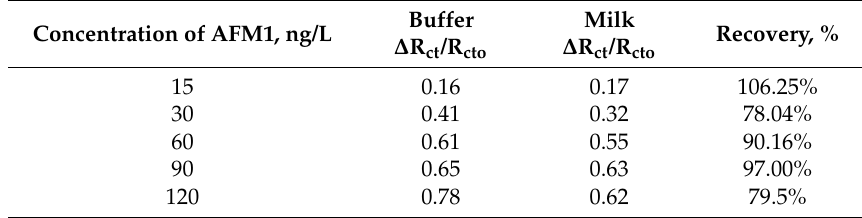
Table 2. Comparison of the EIS response of the aptasensor in a PBS and in spiked milk